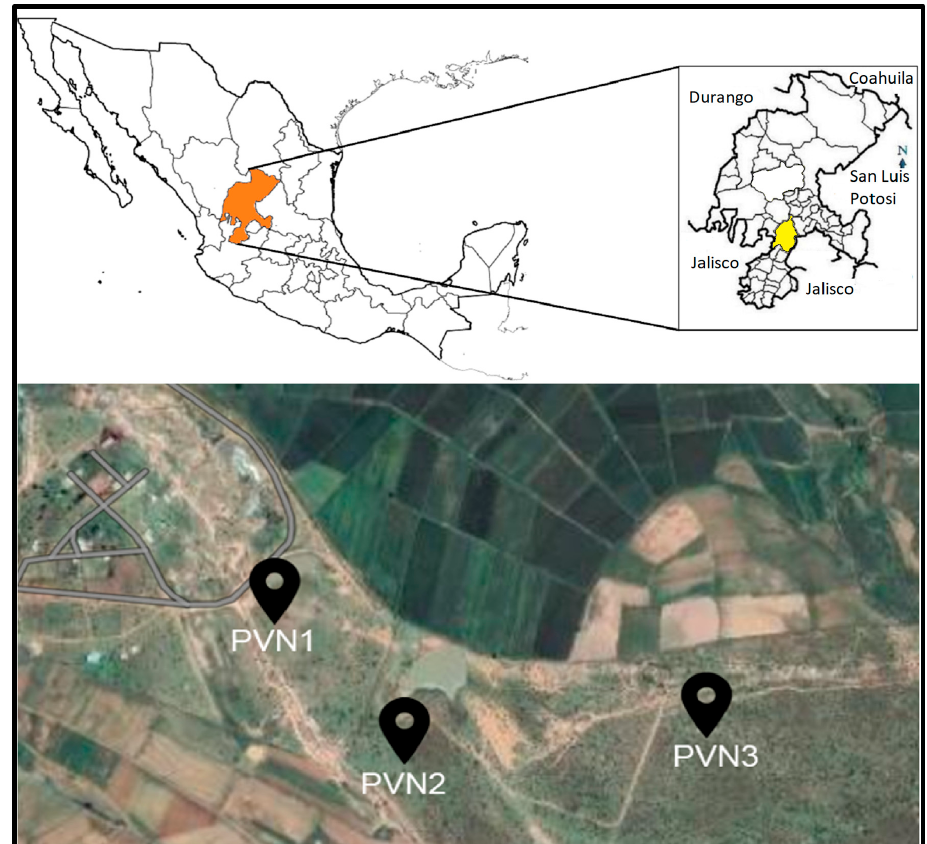
Figure 2. Map of the region from where the samples of Phoradendron villosum were taken: Laguna del Carretero. The samples’ coordinates are PVN 1 (22°16 ′ 23.89 ″ N, 102°47 ′ 56.42 ″ O); PVN 2 (22°16 ′ 14.59 ″ N, 102°47 ′ 48.08 ″ O); PVN 3 (22°16 ′ 16.59 ″ N, 102°47 ′ 28.62 ″ O).